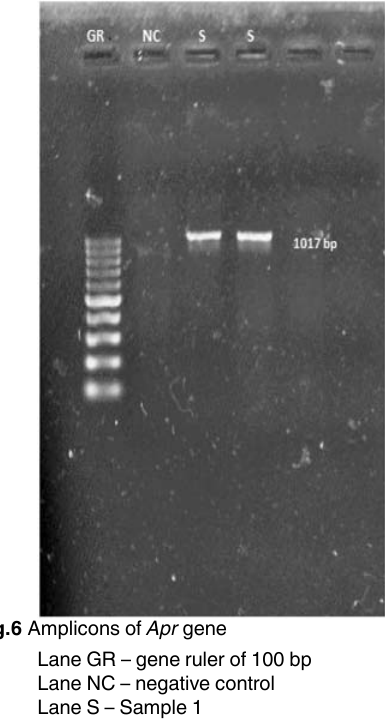
Fig.6 Amplicons of Apr gene Fig.7 Amplicons of Lec A gene